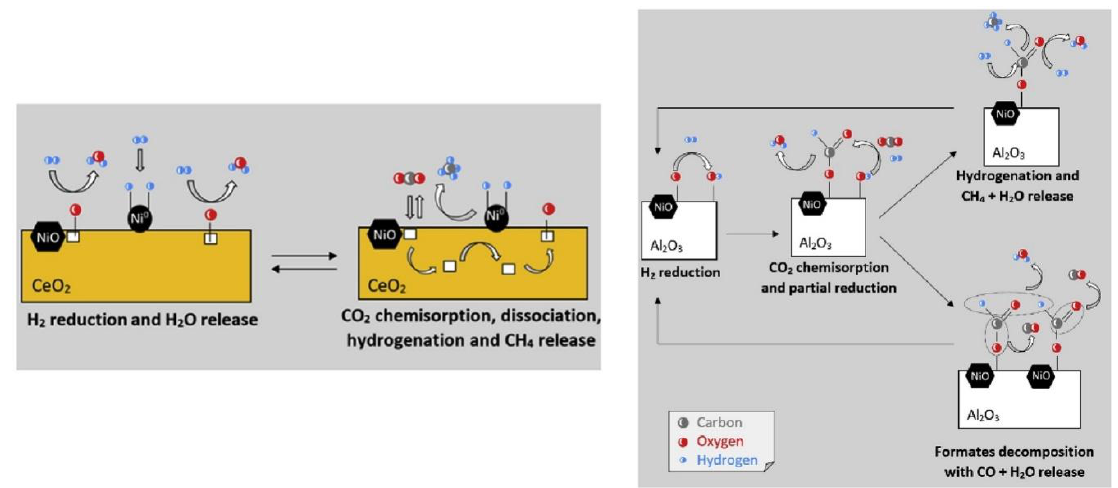
Figure 1. Scheme of the CO 2 + H 2 reaction mechanisms over Ni/CeO 2 and Ni/Al 2 O 3 catalysts. Reproduced with permission from [12]. Copyright: Elsevier, Amsterdam, The Netherlands, 2020.